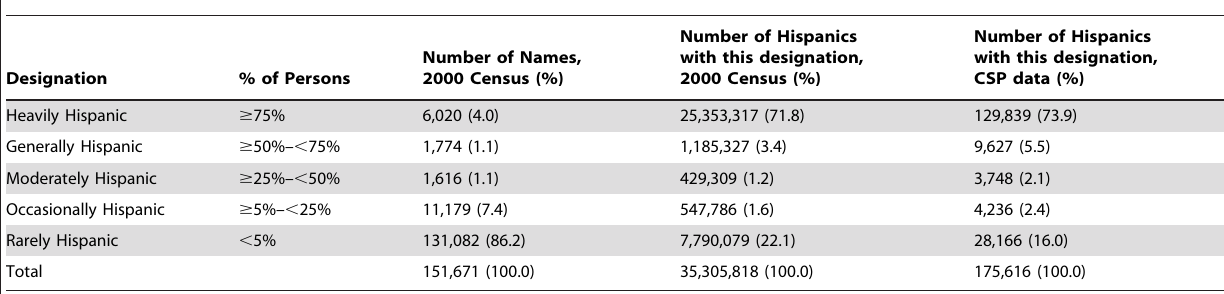
Table 3. Hispanic Surname Classification